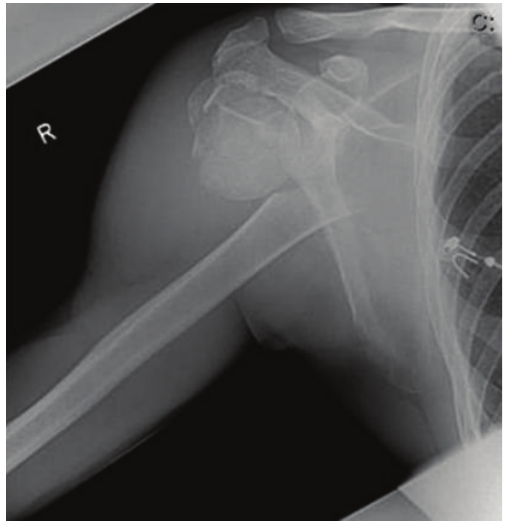
Figure 7: Initial X-ray of the dislocated proximal humeral